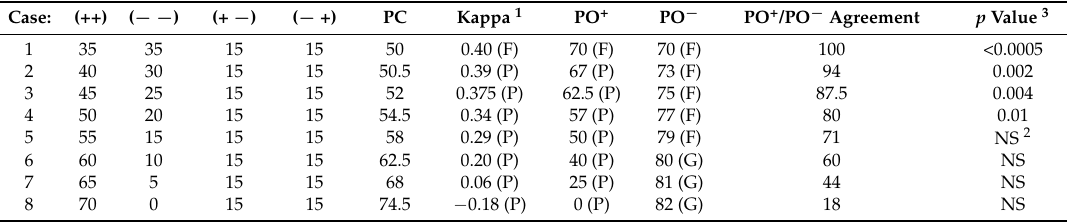
Table 4. Relationship between the Reliability and Accuracy of Pairs of Hypothetical Tasters Judging